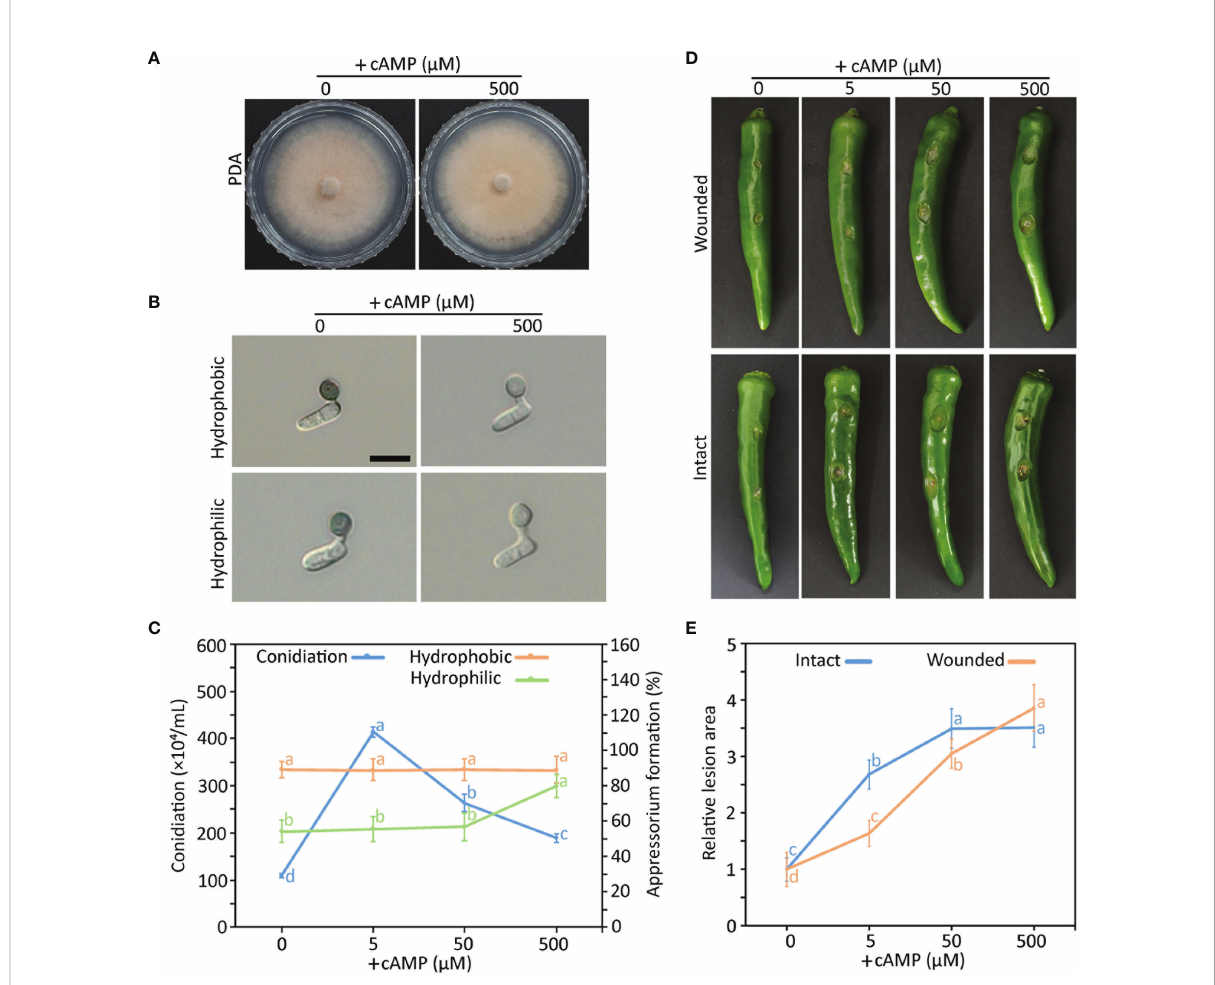
FIGURE 1 Effect of exogenous cAMP on mycelial growth (A) , appressorium formation (B, C) , conidiation (C) , pathogenicity (D, E) of wild-type C scovillei . (A) Mycelial growth. Mycelial agar plugs (5-mm diameter) from 4-day-old MMA were inoculated onto potato dextrose agar (PDA) containing 0 and 500 µM cAMP and cultured for 6 days. (B) Appressorium formation. Conidial suspensions (5 × 10 4 /mL) were dropped onto the hydrophobic surface of coverslips and slide glasses and incubated in a humid plastic box for 16 hours. Scale bar, 10 m m. (C) Quantitative measurements of conidiation and appressorium formation. Mycelial agar plugs (5 mm diameter) from 4-day-old MMA were inoculated onto PDA containing 0, 5, 50, and 500 µM cAMP and cultured under a cycle of 6 days of light and 2 days of darkness. Conidia were harvested in 5 mL of distilled H 2 O. Appressorium formation was measured by counting appressorium-forming conidia among a total of 100 conidia. (D, E) Pathogenicity assays. Intact and wounded pepper fruits were inoculated with conidial suspensions (50 × 10 4 /mL) and incubated in a humid plastic box. After 24 hours, 0, 5, 50, and 500 µM cAMP was added to conidial drops. (D) Photographs of wounded and intact pepper fruits after 6 and 8 days, respectively. (E) Anthracnose lesion size measured using ImageJ. Error bars show standard deviations and different letters in the same group indicate a signi fi cant difference estimated using Duncan ’ s test (P <